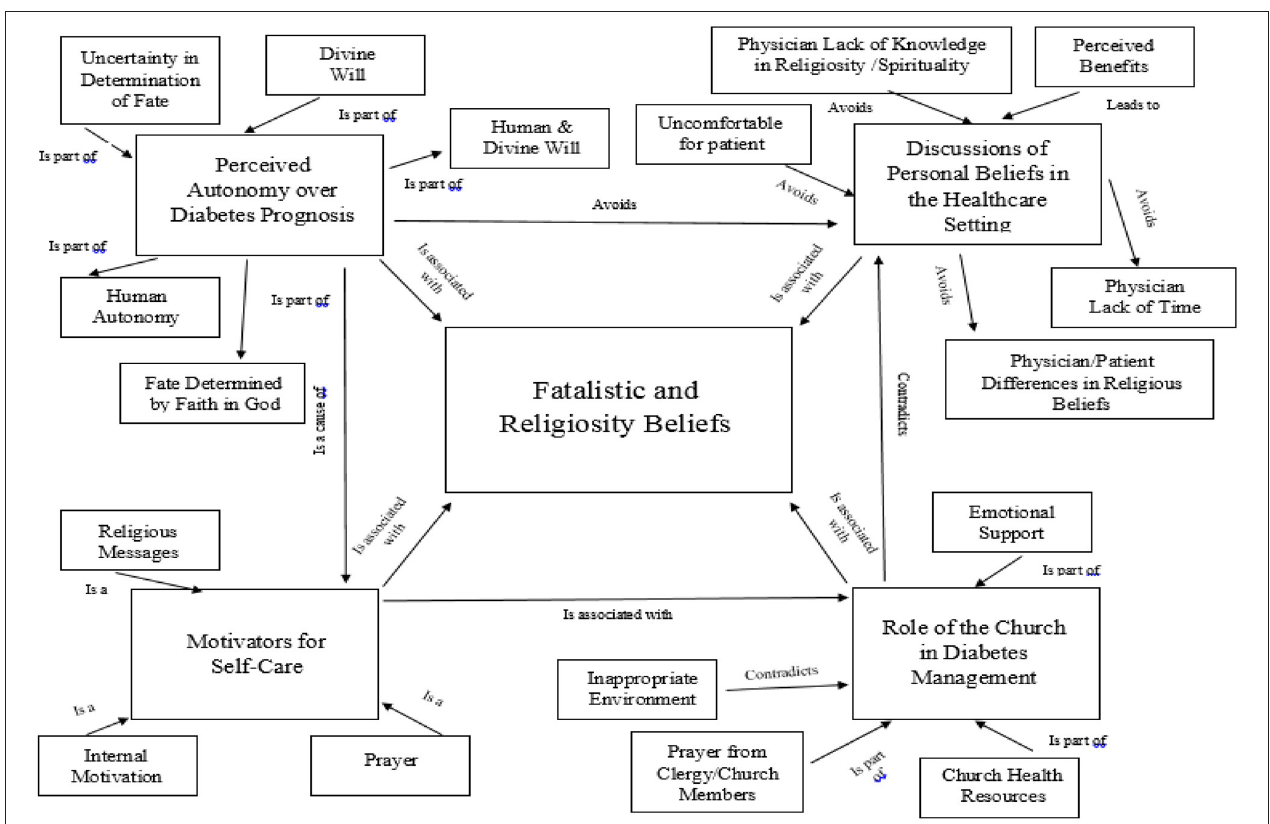
FIGURE 1 | Theme network by level of